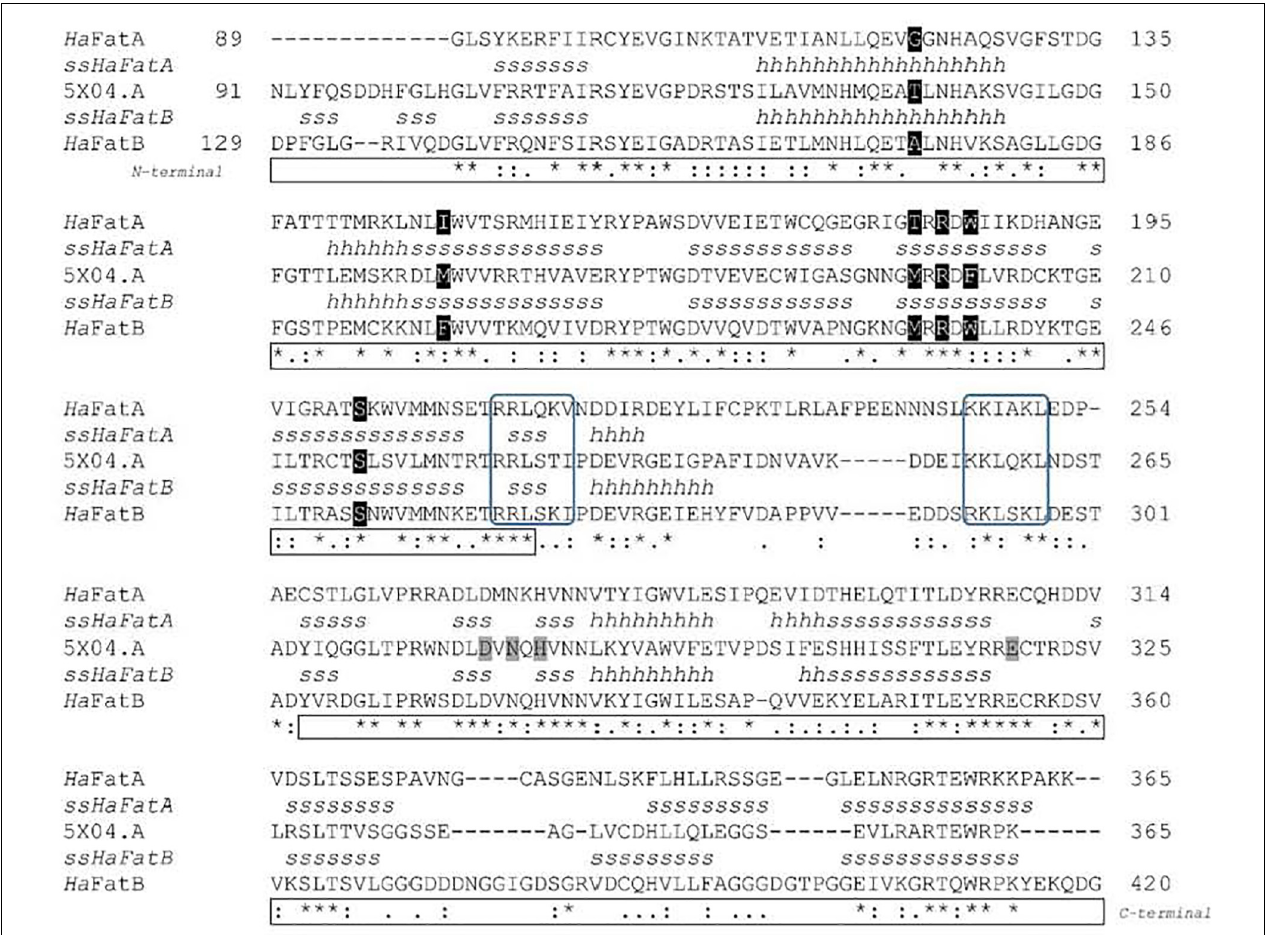
FIGURE 2 | Comparison between the deduced amino acid sequences ( Ha FatA, Ha FatB, and Umbelullaria californica UcFatB) and predicted secondary structures ssHaFatA and ssHaFatB. Asterisks designate identical residues, a colon indicates conservative changes and a dot the weakly conserved changes between the sequences. Structural elements: H, α -helix; S, β -sheet. Residues involved in the substrate binding pocket and catalysis (Feng et al., 2017) are highlighted in black and gray, respectively. Positively charged surface patches (Serrano-Vega et al., 2005; Jing et al., 2018), and the N- and C-terminal domains are boxed in blue and black,